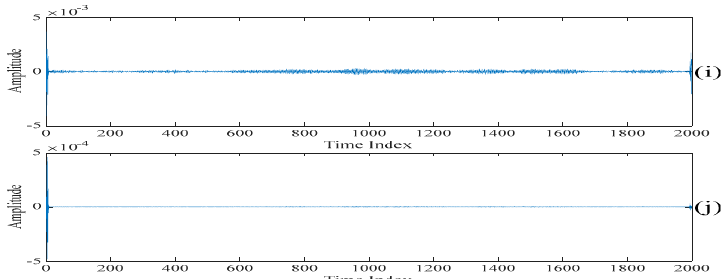
Figure 5. The singular spectrum analysis components obtained by performing the singular spectrum analysis on the filtered electroencephalogram. ( a ) The first singular spectrum analysis component. ( b ) The second singular spectrum analysis component. ( c ) The third singular spectrum analysis component. ( d ) The fourth singular spectrum analysis component. ( e ) The fifth singular spectrum analysis component. ( f ) The sixth singular spectrum analysis component. ( g ) The seventh singular spectrum analysis component. ( h ) The eighth singular spectrum analysis component. ( i ) The ninth singular spectrum analysis component. ( j ) The tenth singular spectrum analysis component.